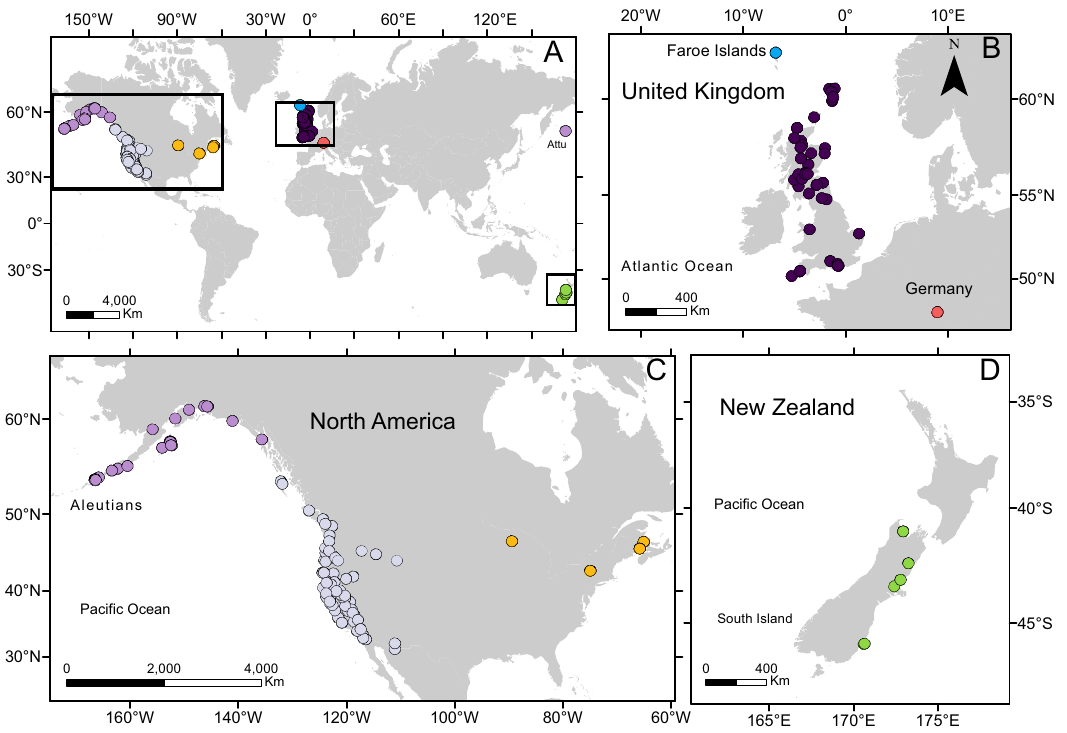
Fig. 1 Global sampling of Mimulus guttatus populations. A Overview of all sampled population. B European populations. C North American populations. Populations in the west are native, while orange symbols represent invasive populations in eastern North America. D New Zealand populations. The symbols for the two southernmost populations in the South Island are